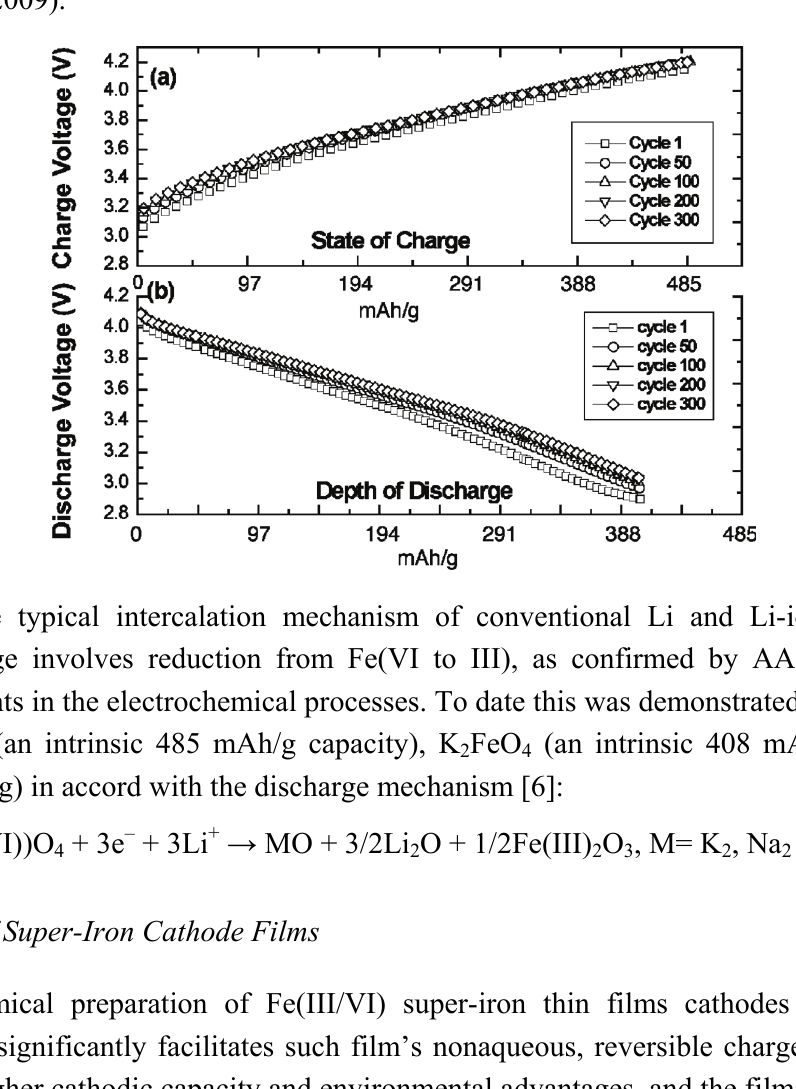
FeO cathode film. (a) Cell potential 2 4